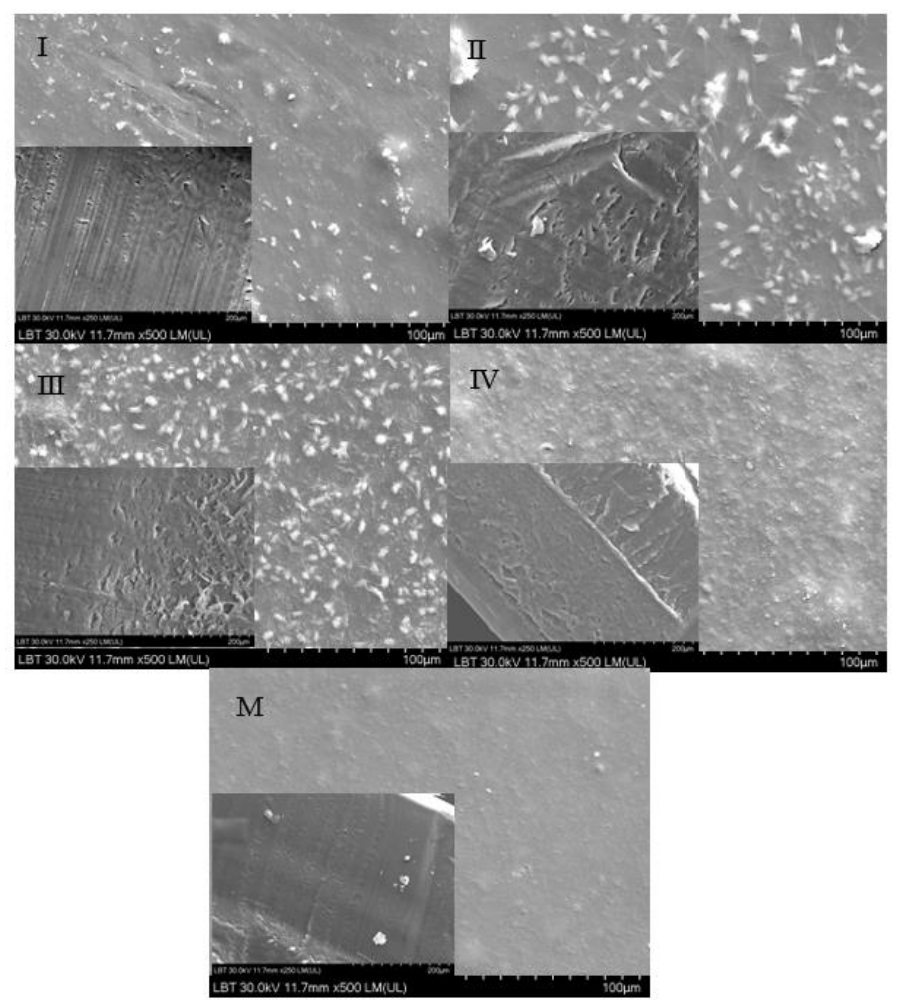
Figure 6. SEM images of the surface (big picture) and the cross-section (inside smaller picture) of hydrogel samples based on whey and gelatin without GO (M) and with increasing GO concentrations (I, II, III, and IV).